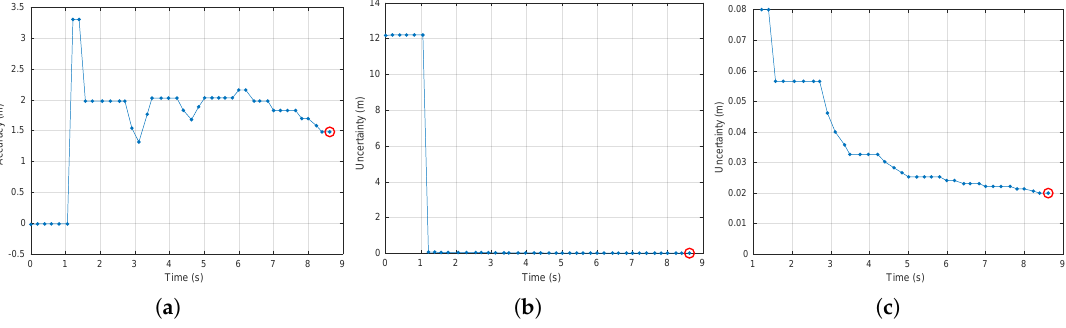
Figure 10. Evolution over time of the measures of filtering performance for the Hokuyo sensor. The red circle indicates the instant of convergence (43 filtering steps). ( a ) Accuracy. ( b ) Uncertainty. ( c ) Zoomed view (vertically) of the